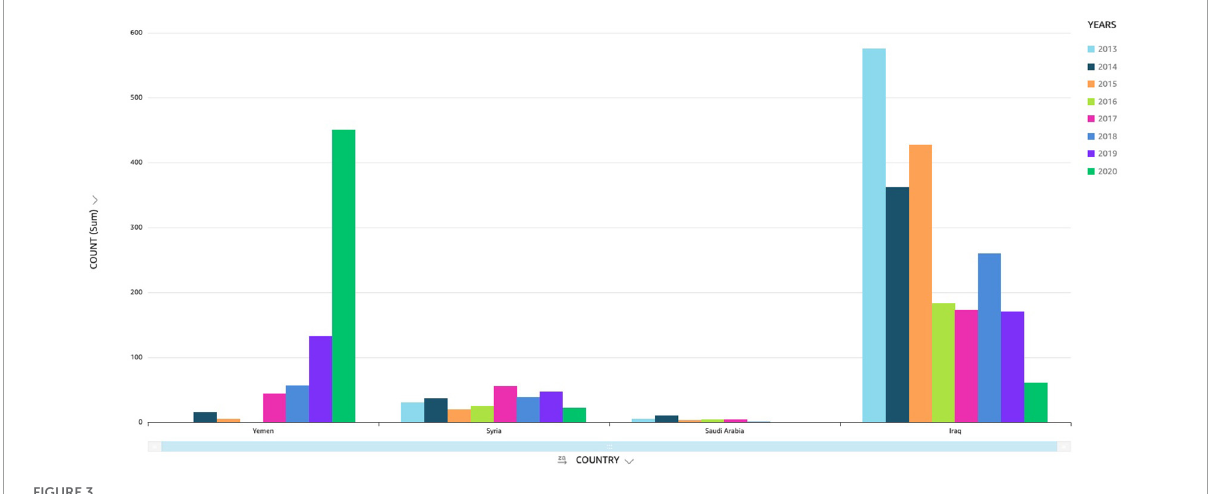
FIGURE3 Cases of visceral leishmaniasis reported